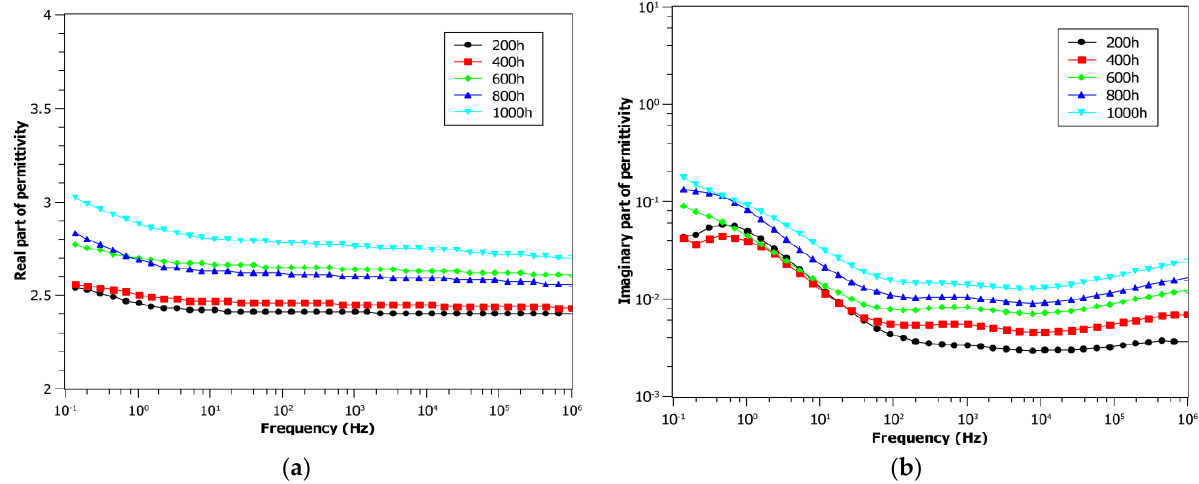
Figure 2. Real ( a ) and imaginary ( b ) part of the permittivity for cables aged at 85 °C and 0.42 kGy/h as a function of aging time.